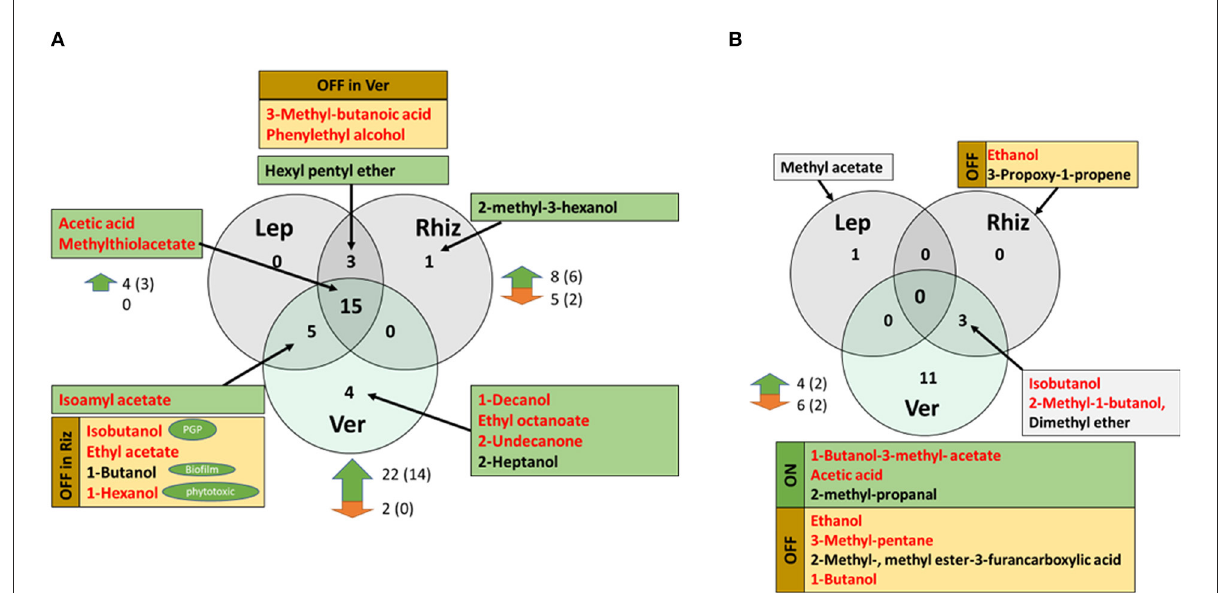
FIGURE2 (A) Common and unique VOCs which were produced by S. plymuthica HRO-C48 when incubated with Rhizoctonia solani AG2 (Rhiz), Leptospheria maculans MB 158 (Lep) and Verticillium longisporum ELV 43 (Ver), respectively. The substances that were not found in the untreated control, thus were “switched on” in any of the treatments are highlighted in green. The substances that were switched off in any of the treatments but found in other treatment(s) and in the control, are highlighted in yellow and indicated with the “OFF” sign for a respective treatment. Red font indicates that the substances were mentioned in the scientific literature as antimicrobial, while other predicted functions are indicated in green ovals (“PGP” = plant growth promoting, “Biofilm” = effect on the biofilm formation; “phytotoxic” – predicted toxic effect on plants). Black arrows point to the respective set these substances belong to. The numbers to the right of the green and red arrows mean the number of strongly (significant or over 100%) up- or downregulated volatiles due to the treatment with fungal volatiles, respectively. The number of substances that may have antimicrobial function are shown in brackets. For references please see Supplementary Table S3. (B) Common and unique VOCs that were produced by R. solani AG2 (Rhiz), L. maculans MB 158 (Lep) and V. longisporum ELV 43 (Ver), when incubated with S. plymuthica HRO-C48 VOCs. The substances that were not found in the untreated control (“switched on” in any of the treatments) are highlighted in green and indicated with “ON”. The substances that were switched off in any of the treatments but found in other treatment(s) and in the control, are highlighted in yellow and indicated with the “OFF” sign for the respective treatments. Gray boxes indicate that the respective substances were also detected in the untreated control. Red font indicates that the substances were mentioned in the scientific literature as antimicrobial or inducing some responses in microorganisms. The arrows point to the respective set these substances belong to. The numbers to the right of the green and red arrows indicate the number of strongly (significant or over 100%) up- or downregulated volatiles due to the treatment with bacterial volatiles, respectively. The amount of the substances that may have antimicrobial function are shown in brackets. For references please see Supplementary Table S4.